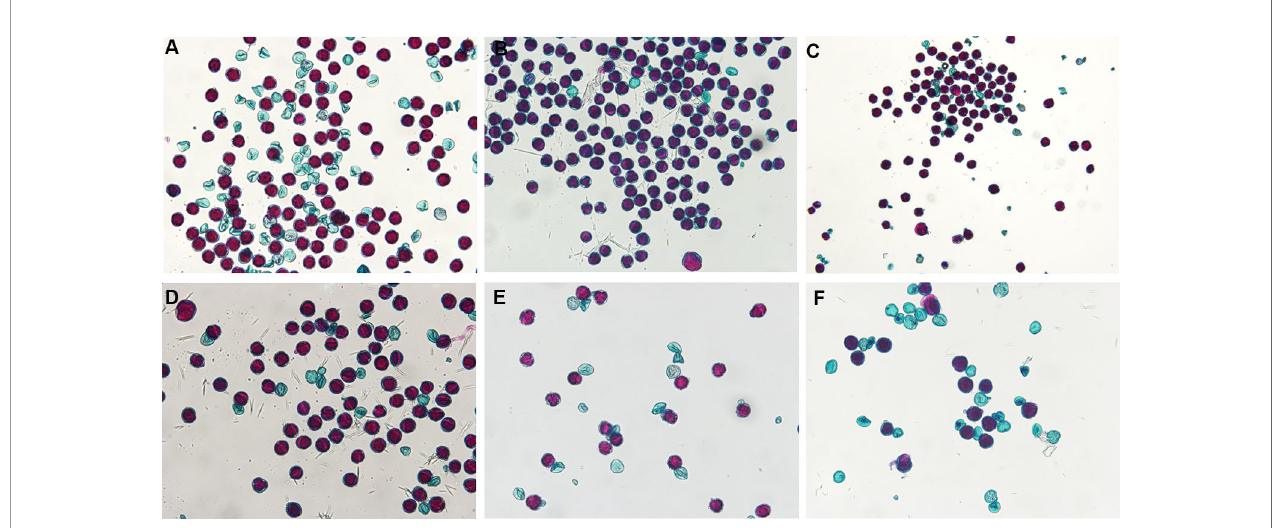
FIGURE 1 | Stained pollen of Hydrangea macrophylla diploid cultivars Decatur Blue (A) , Oakhill (B) , and Zaunkoenig (C) , and triploid cultivars Blaumeise (D) , Nachtigall (E) , and Taube (F) . Fresh pollen was stained with modi fi ed Alexander's stain and observed after 30 min at 10× magni fi cation using an Olympus BX-60 compound microscope with an Olympus Q Color 5 digital camera for image